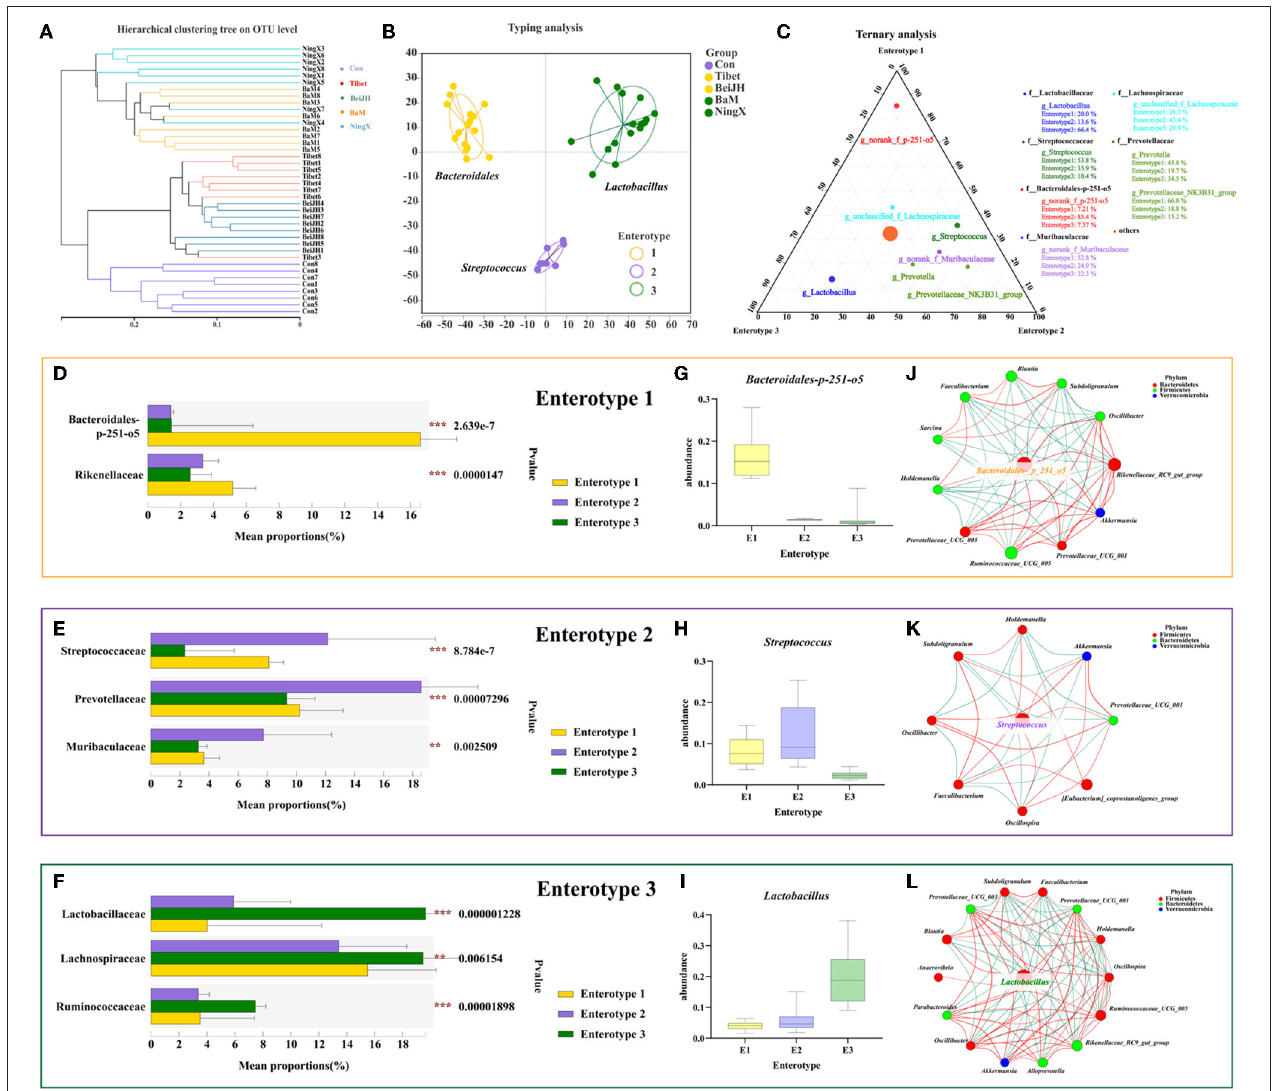
FIGURE 5 | Compositional analysis of enterotype-like clusters. (A) Hierarchical clustering tree on OTU level. (B) The classification of enterotype among five pig breeds. (C) Ternary analysis for determinants in three enterotypes. Dominant bacteria in (D) Enterotype 1, (E) Enterotype 2, and (F) Enterotype 3. The abundance of Bacteroidales-p-251-o5 (G) , Streptococcus (H) , and Lactobacillus (I) , in three enterotypes, specifically. (J–L) Enterotype characteristic bacteria were located in the center of each enterotype network interaction map. ** P < 0.01; *** P <